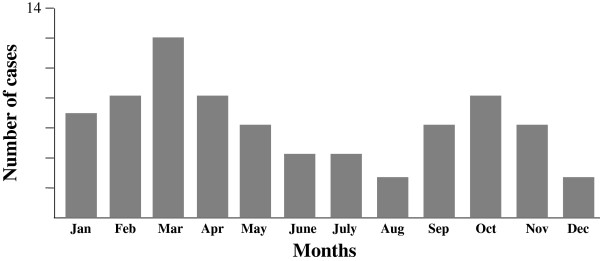
Monthly incidence of acute cervical lymphadenitis and infections of the retropharyngeal and parapharyngeal spaces.